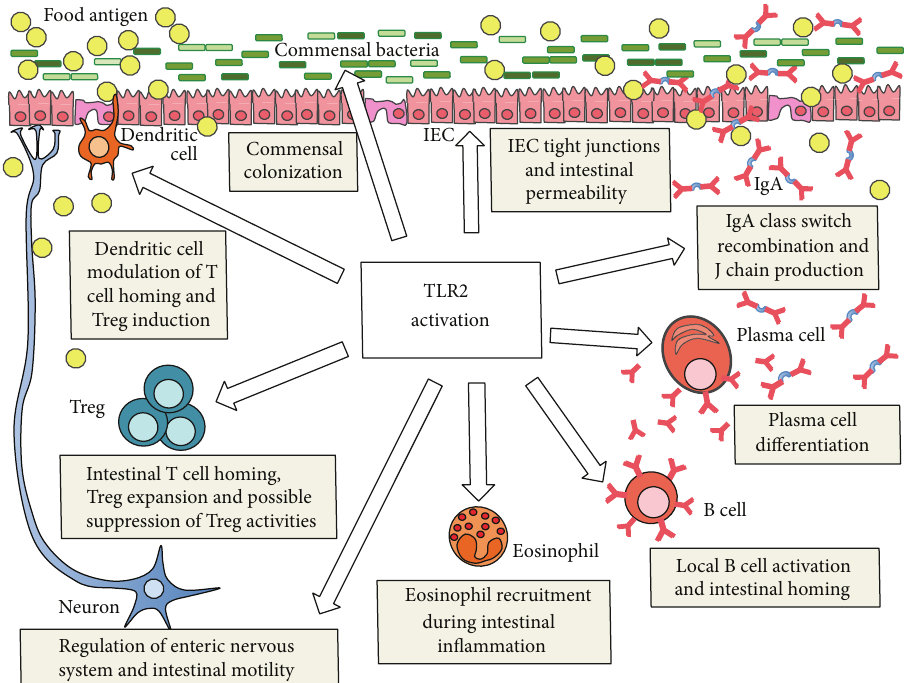
Figure 1: Proposed involvement of TLR2 in oral antigen responses of the intestinal microenvironment. This figure outlines several suggested roles of key intestinal cell types in the regulation of oral tolerance to oral antigens in the context of TLR2